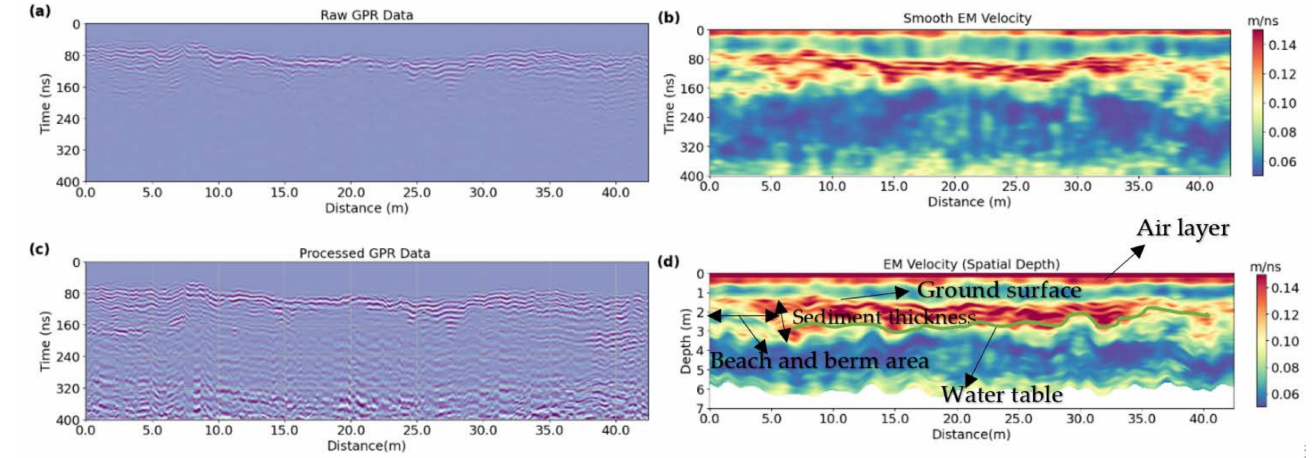
Figure 17. ( a ) Topographically corrected raw GPR data, ( b ) predicted velocity map in the time domain, ( c ) processed GPR data, and ( d ) velocity map in the depth domain.